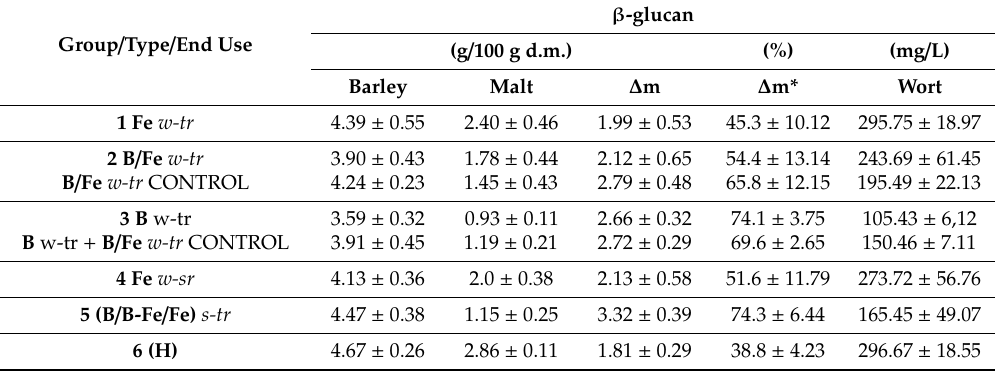
Table 3. The average share and mass di ff erence in β -glucan content in barley, malt, and wort by tested purpose